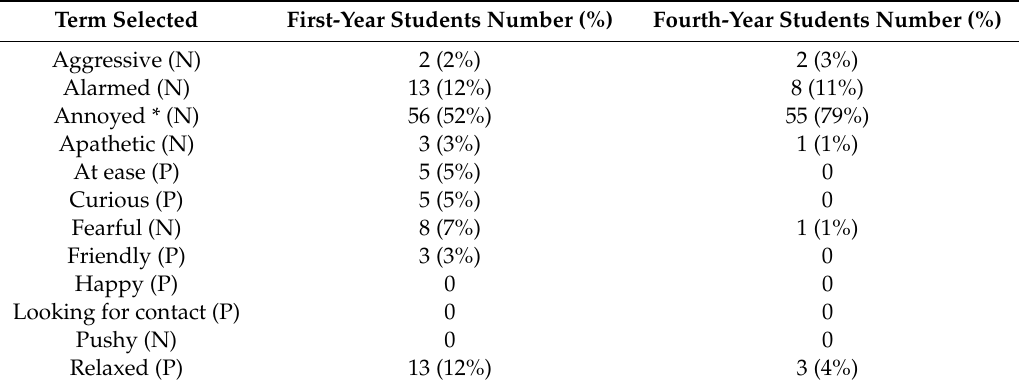
Table 3. Number and percentage of students that selected each of the 12 pre-selected terms to describe the behaviour of the horse in picture.